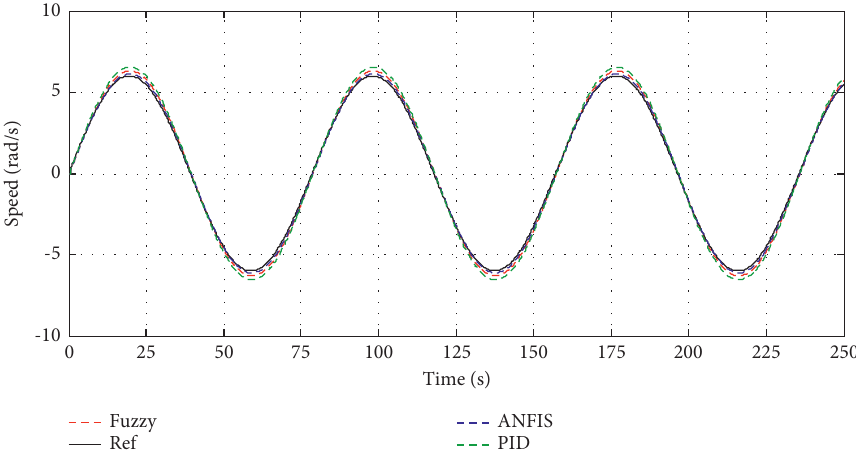
Figure 9: The result of three types of controllers ANFIS, Fuzzy, and PID.